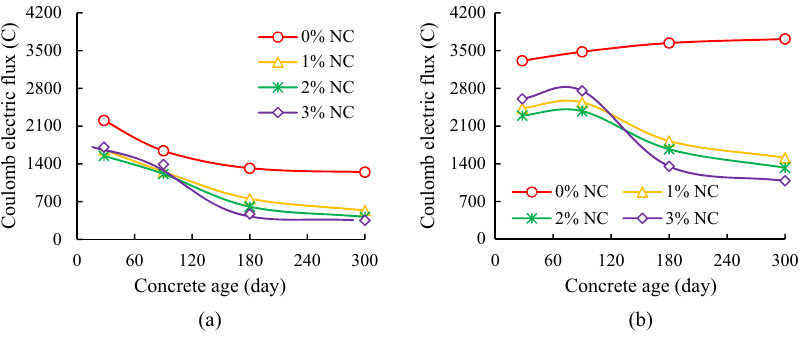
Figure 3: Concrete Coulomb electric fl uxes with di ff erent levels of NC replacement. ( a ) SC concrete ( b ) AC